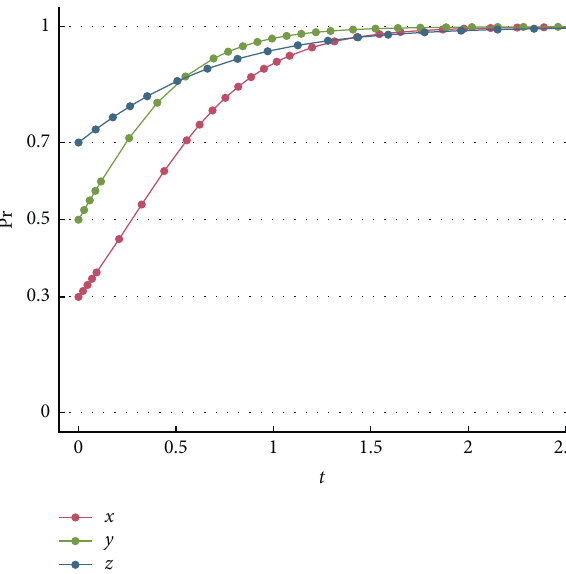
Figure 6: The final evolution result of E strategy.